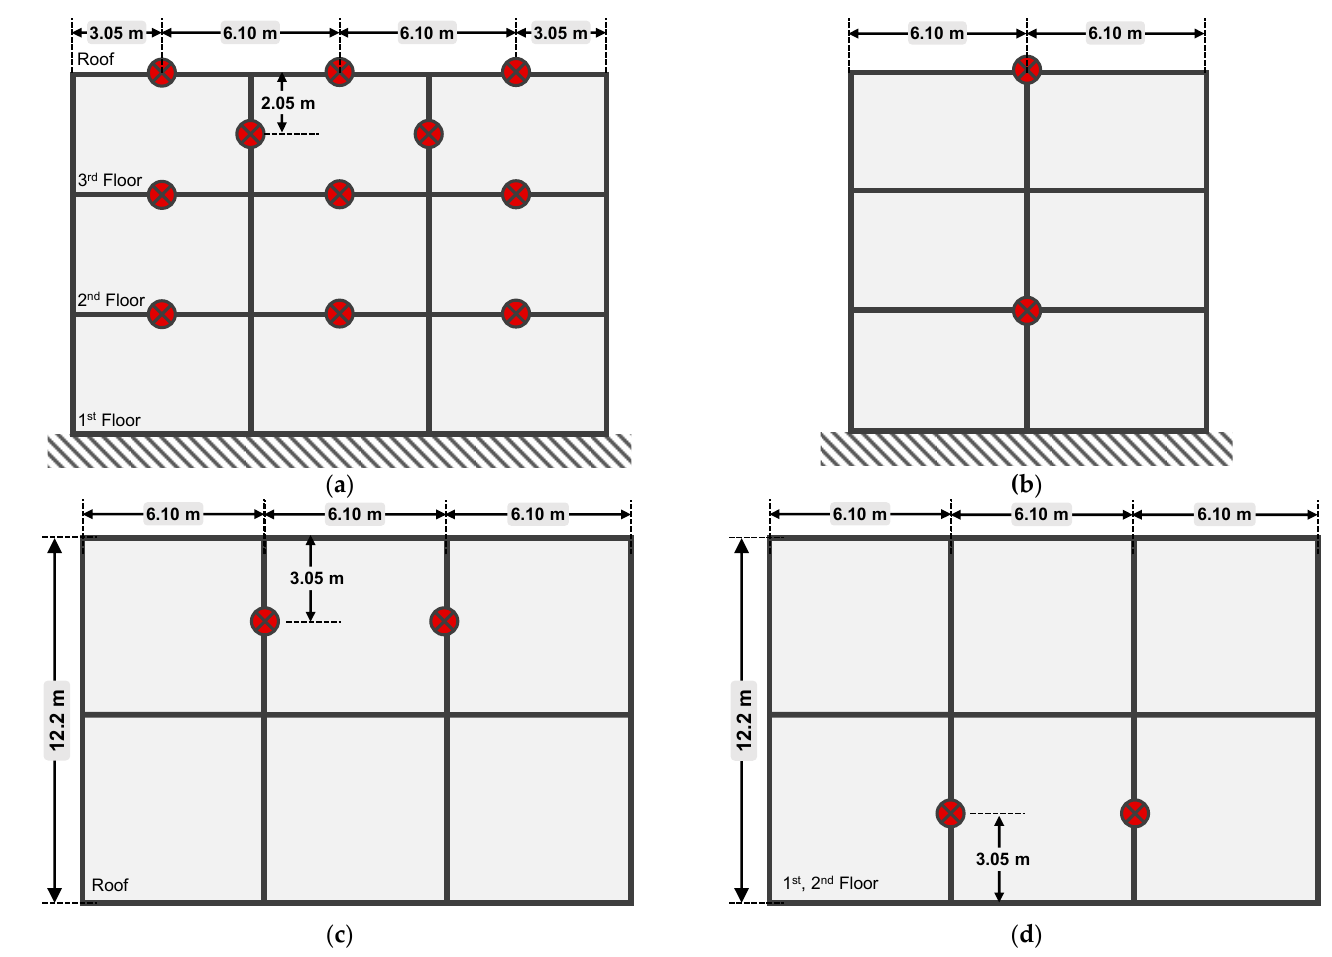
Figure 6. Pressure gauge locations on the test structure: ( a ) Front (south) elevation, directly loaded face; ( b ) Side (east and west) elevation; ( c ) Roof; ( d ) First and second floor (interior pressure gauges). For redundancy, a total of nine (9) DGs, three (3) per floor level, were used to measure the lateral displacement history at each one of the three floor levels. All DGs were mounted to the back side of the structure i.e., the elevation opposite to the one directly loaded from the blast pressure. The DGs were placed at the floor levels and were mounted to a non ‐ responding steel ‐ frame instrumentation tower, which is shown in Figure 7. For estimating the peak axial load on the chevron braces of the LFRS, a total of 24 SGs were attached to the two brace lines along the load direction (Figure 2a) i.e., braces along gridlines B and C. Specifically, a pair of two SGs were attached at each one of the 12 HSS brace members. Each SG pair was located at the midspan of each brace with the two SGs glued to the two opposite sidewalls of the HSS tube brace member. Figure 8 shows the locations and IDs of these SGs. More strain gauges were installed at other critical members such as columns and